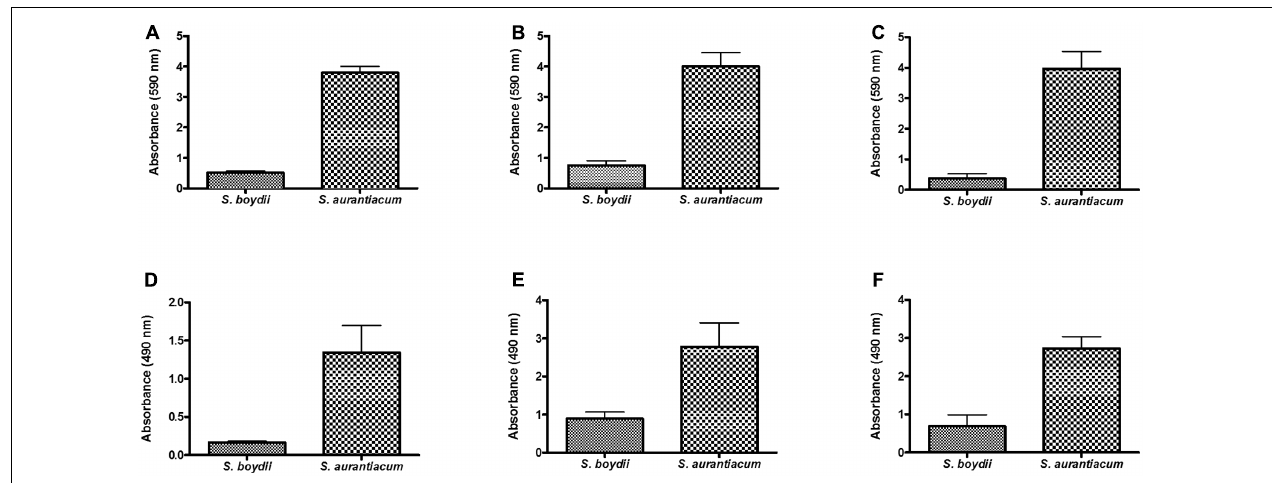
FIGURE 7 | Comparison of biofilm formation by S. boydii and S. aurantiacum on three different surfaces. Biofilm formation was evaluated after 24 h of growth. The total biomass of the biofilms was quantified using a crystal violet assay (A,B,C) , and the metabolic activity of the cells inside the biofilms was quantified using a XTT-reduction assay (D,E,F) . Three different surfaces were used, including glass Petridish bottoms (A,D) , polystyrene (B,E) , and catheters (C,F) . Statistical differences ( P < 0.05) are represented by asterisks.